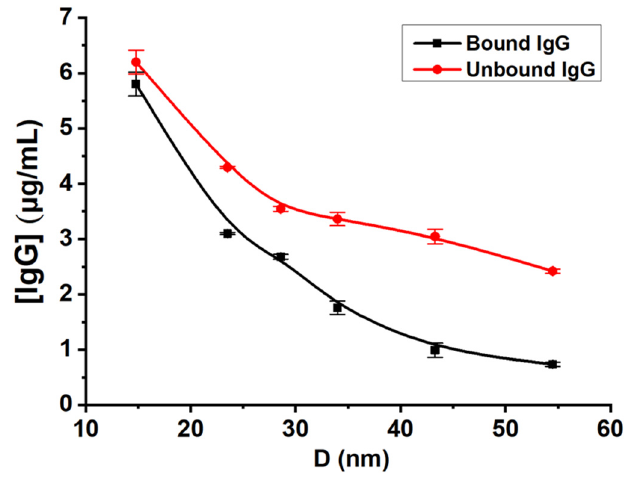
Figure 4. Calculated concentrations of immunoglobulins in supernatants and in conjugates ( y -axis) for GNPs of different diameters ( x -axis).3.5. Determination of the Antigen-Binding Activity of An- tibodies after Conjugation.